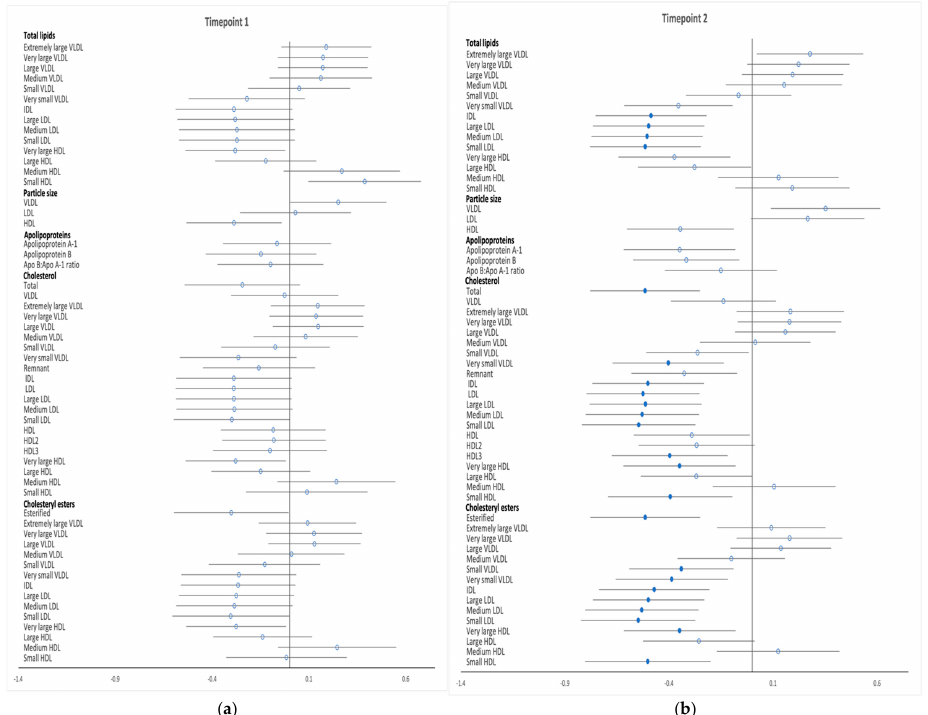
Figure 1. Differences in total lipids in all lipoprotein subclasses, particle size, apolipoproteins, free cholesterol and cholesteryl esters between high-risk women who developed GDM and those who did not develop GDM at timepoints 1 ( a ) and timepoint 2 ( b ). Data points show the SD difference at baseline (timepoint 1) and at the time of OGTT (timepoint 2). Positive associations with GDM are shown to the right, negative associations are shown to the left. Closed blue circles represent FDR-corrected p values of